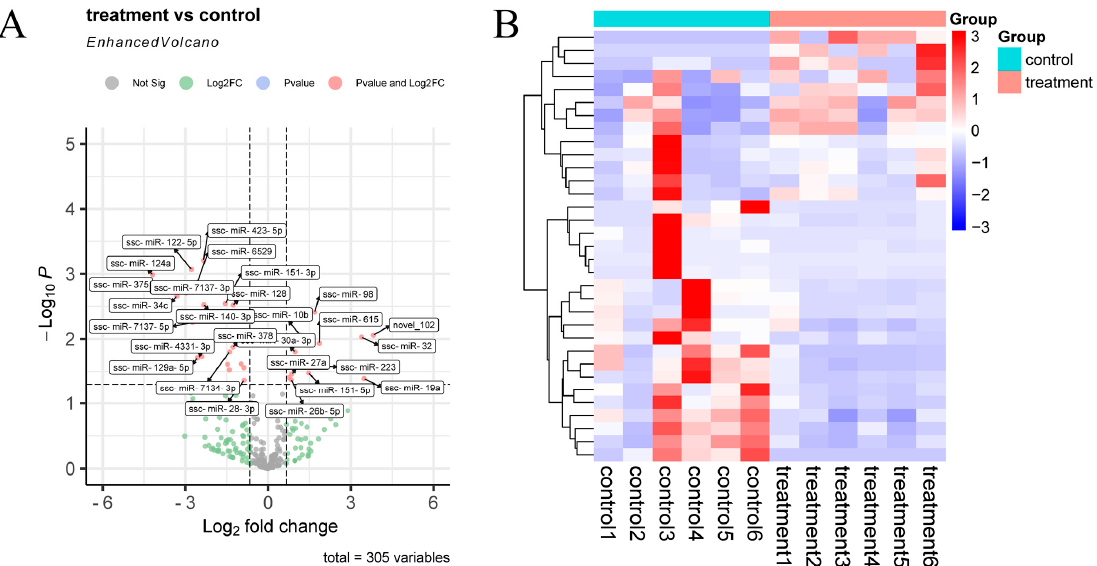
7 of 16 Figure 2. Overview of the small RNA transcriptome data. ( A ) Length distribution of read counts of serum exosome samples (nt = nucleotides); ( B ) rate of 12 samples mapped to the reference genome. 3.4. Differentially Expression Analysis of miRNAs